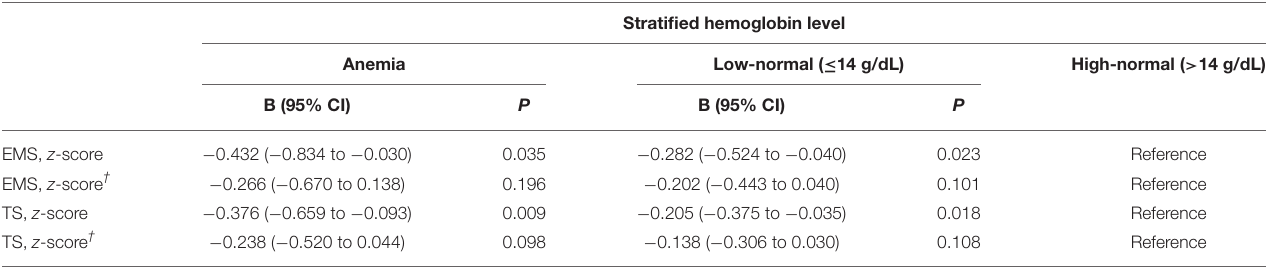
TABLE 4 | Results of multiple linear regression analyses for assessing the relationship between hemoglobin strata and cognitive performance in non-demented older adults.